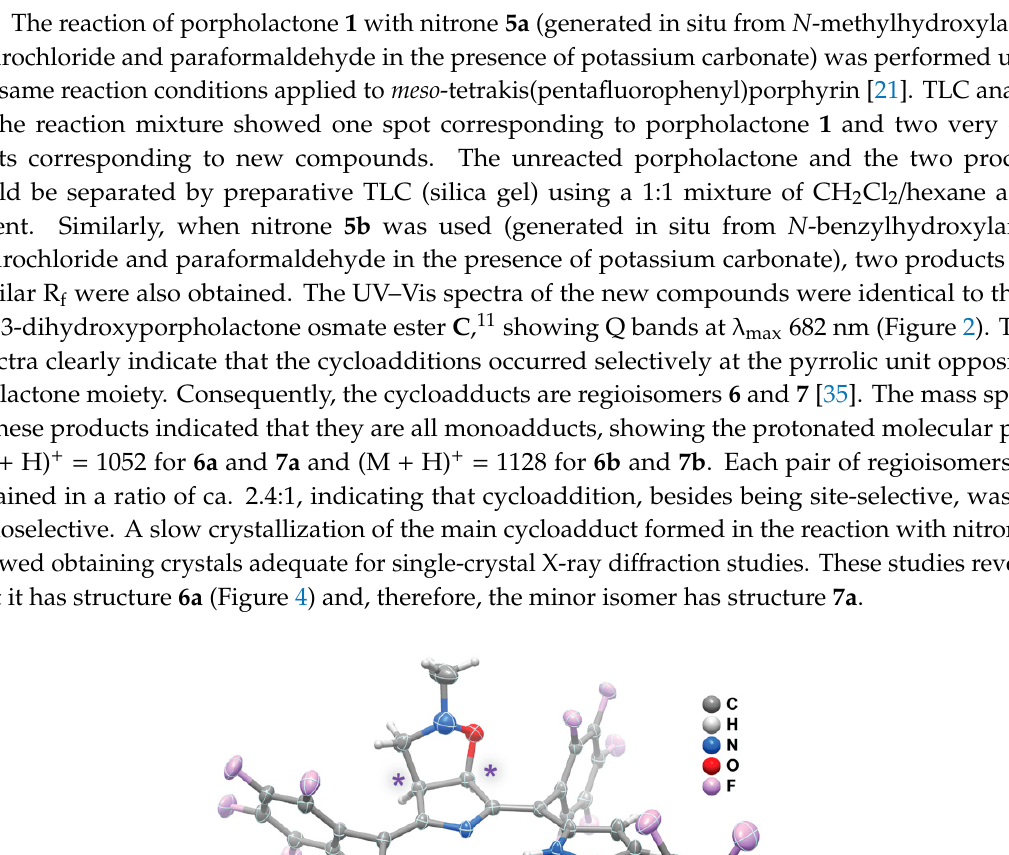
Figure 3. Ball-and-stick representation of the pyrrolidine-fused porpholactone derivative 3b . The chiral centers are indicated by an asterisk. Hydrogen atoms were omitted for clarity reasons.